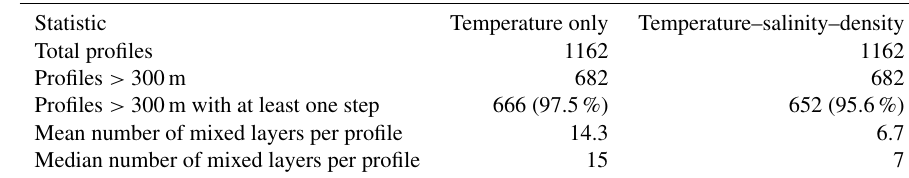
Figure 6. Classification of a glider profile from the tropical North Atlantic demonstrating the differing output of VDB and our classifier. The three profiles are VDB (i), our classifier when operating on temperature-only preliminary classification (ii), or temperature, salinity and density preliminary classification (iii). The profile is from dive 119 by SG637, yearday 41.6 (12 February). The first profile is at the unaltered temperature and salinity; the subsequent profiles are offset by 0.8 ◦ C (a) and 0.2gkg − 1 (b) for clarity. Table 2. Summary statistics on all profiles. Total profiles is the number of profiles classified. Total profiles > 300m is the number of profiles where the glider profiled deeper than 300m. The mean and median numbers of mixed layers per profiles are the average number of mixed layers identified per profile. The two columns show these statistics when preliminary classification was conducted with only temperature profiles and when preliminary classification was conducted with temperature, salinity and density